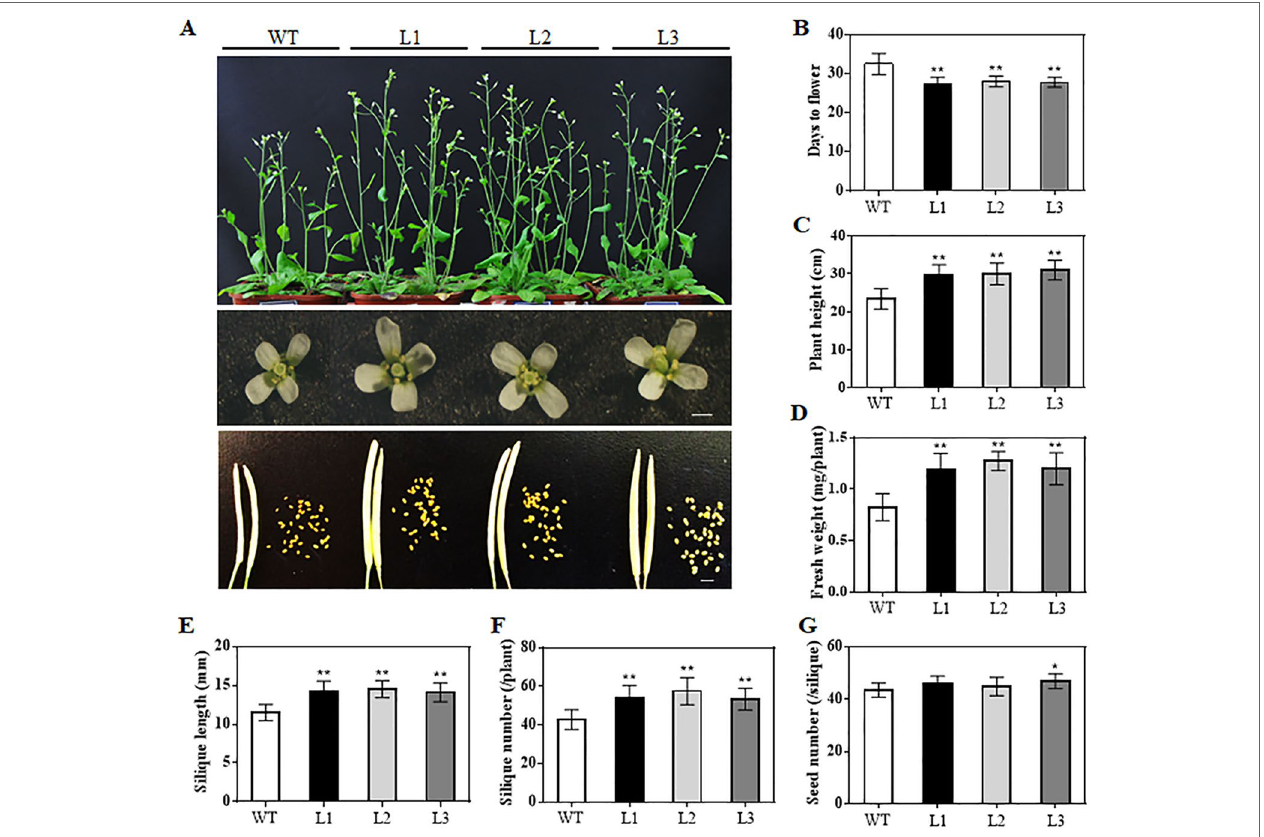
FIGURE 7 | Phenotypic analyses of the TaAP2-10-5D transgenic Arabidopsis at reproductive stages. (A) Comparisons of the whole plants, flower sizes and silique sizes between WT and transgenic plants. Bar = 1 mm. (B – G) Flowering times (B) , plant height (C) , fresh weight (D) , silique length (E) , silique number (F) and seed number per silique (G) of WT and transgenic plants. Mean values were calculated from 10–20 biological replicates, with error bars representing standard deviations. Statistically significant differences are indicated: *, P < 0.05; **, P < 0.01 (Student’s t